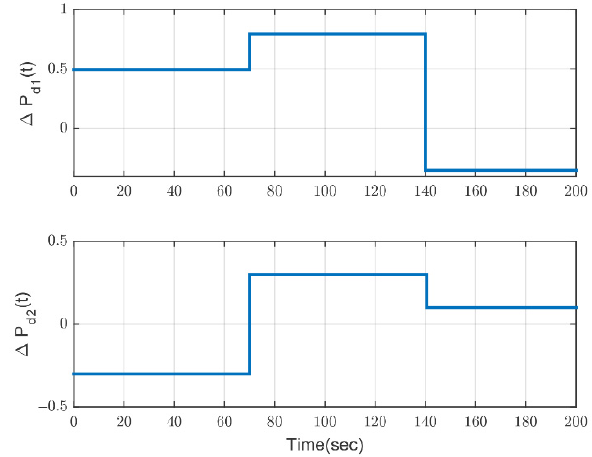
Figure 9. Random load demand change entered to both areas.